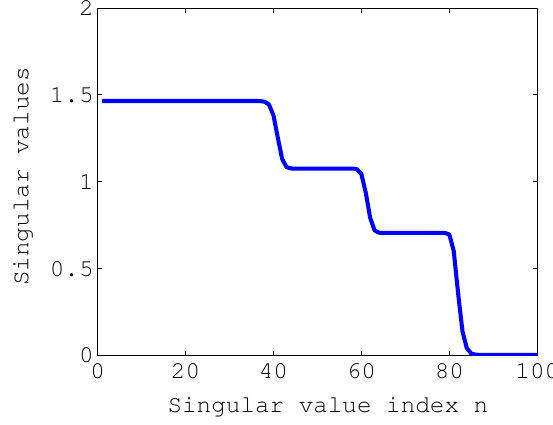
Figure 5: Illustration of how to rearrange the frequency bands to obtain (13).